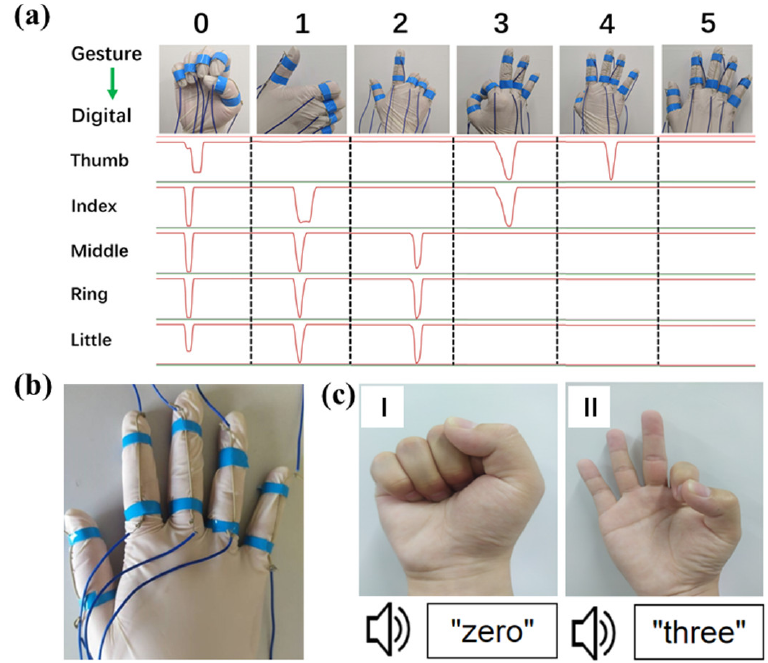
Figure 5. ( a ) Output distributions of electrical signals corresponding to five digital gestures (0, 1, 2, 3, 4 and 5). ( b ) Photograph of the five fingers completely extended initial state. ( c ) Gestures of 0 and 3 were translated into text and voice.